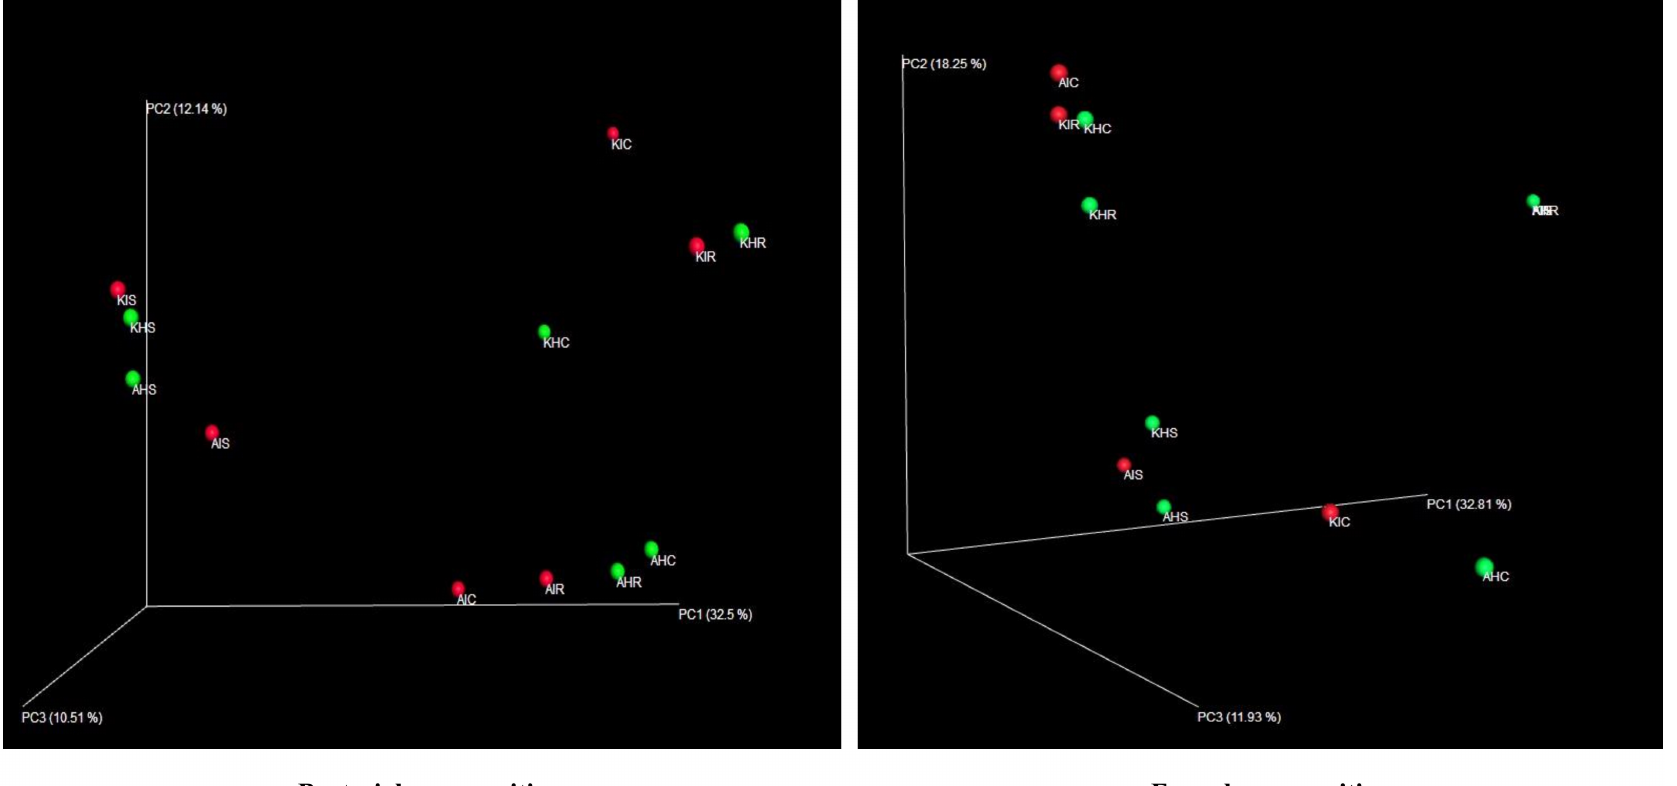
Figure 3. Rhizosphere, root, and corm samples of banana showing di ff erences in their compositions and structure in bacterial and fungal communities of both locations. Principal coordinate analysis (PCoA) of pairwise, showing jackknife-supported confidence ellipsoids. The first three principal axes are shown. Principal coordinate analysis based on Euclidean distances. A: Arusha; C: Corm; H: Asymptomatic; I: Symptomatic; K: Kilimanjaro; R: Roots; S: